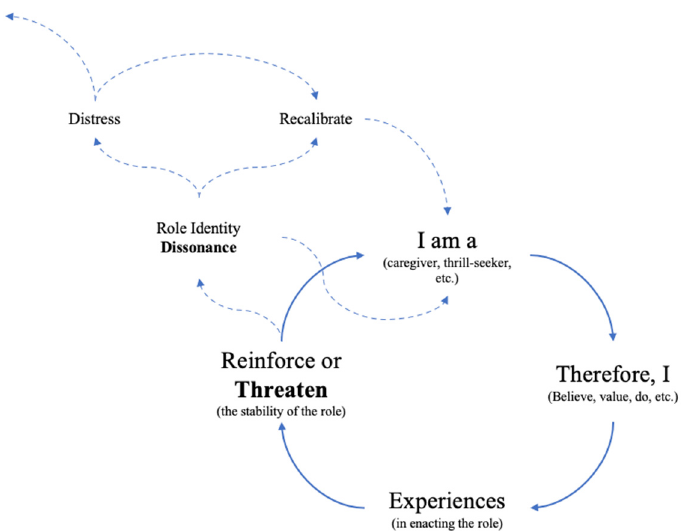
Figure 1. Process diagram illustrating the development and possible resolution paths of role identity dissonance in the context of paramedic role identity. “I am” refers to the concept of self in relation to an espoused role identity. The role identity, in turn, prescribes a set of beliefs, values, actions, etc. (“Therefore, I”). “Experiences” are events and interactions in enacting the role that have the potential to either reinforce or threaten the stability of the individual’s sense of self in relation to the role that they identify with. Where experiences threaten the stability of the role identity, dissonance can result and may lead to potentially significant distress or prompt a recalibration of the individual’s understanding of their sense of self, the role, or both (with potential paths indicated by dashed lines).